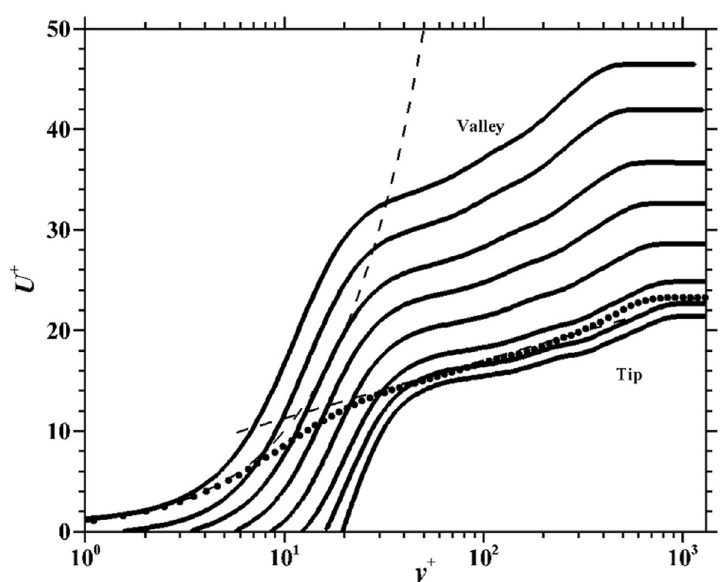
Fig. 8 Van Driest transformed averaged velocity distribution normalized by wall viscous